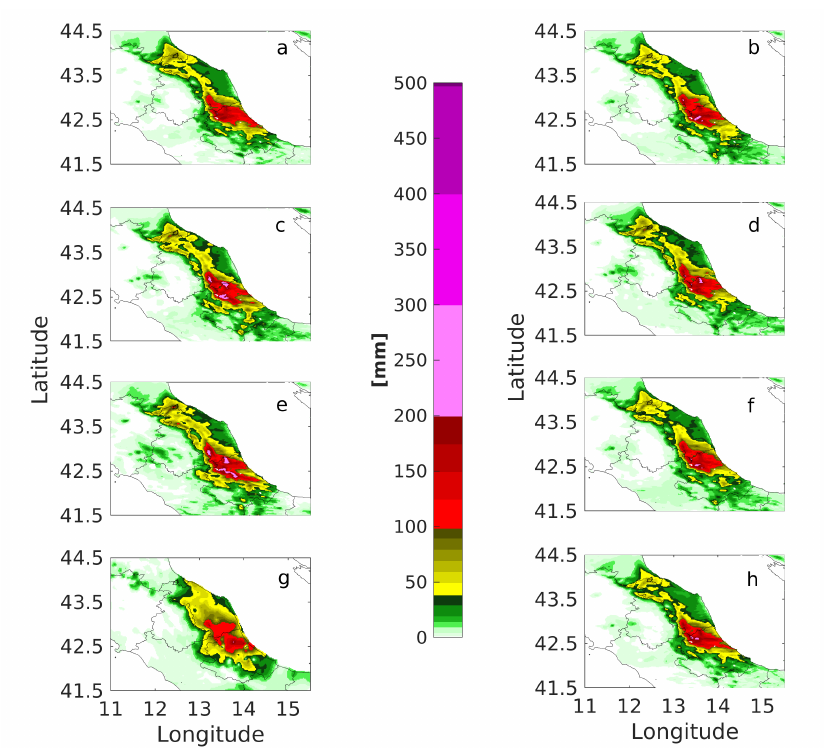
Figure 13. GFS-driven cases. QPF values for the 12 h time period from 18UTC on 9 September 2017 to 06UTC on 10 September 2017, where a = SST, b = SM, c = WIND, d = ZTD_INSAR, e = ZTD_GNSS3h_1ist, f = WIND+SM+ZTD_INSAR_GNSS3h_1ist, g = OBS, h = OL. For details about the 3DVAR approaches the reader is referred to the main